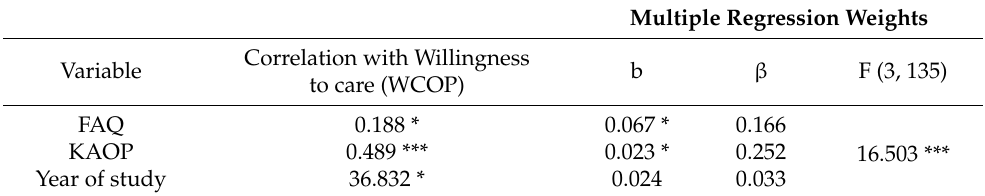
Table 5. Correlations and results from the regression analysis (N =